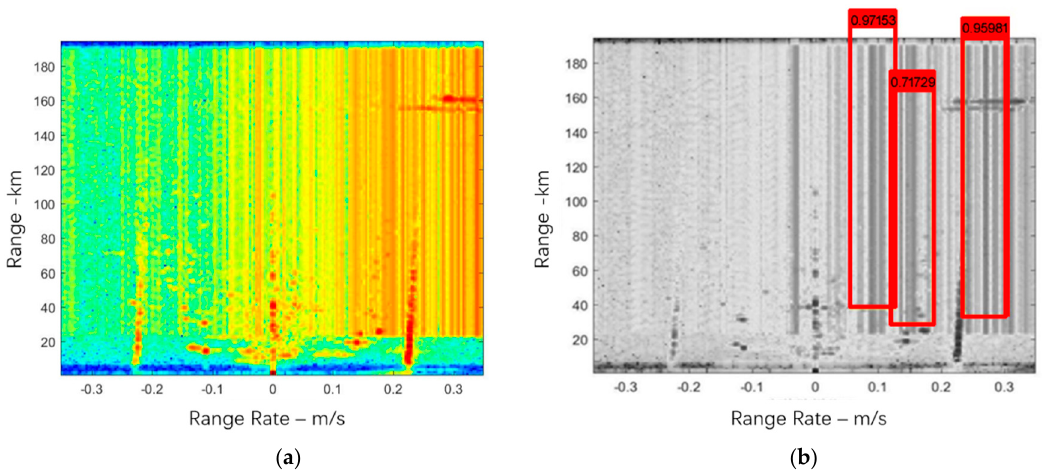
Figure 5. The original RD spectrum images with RFI ( a ) and the detection results ( b ).